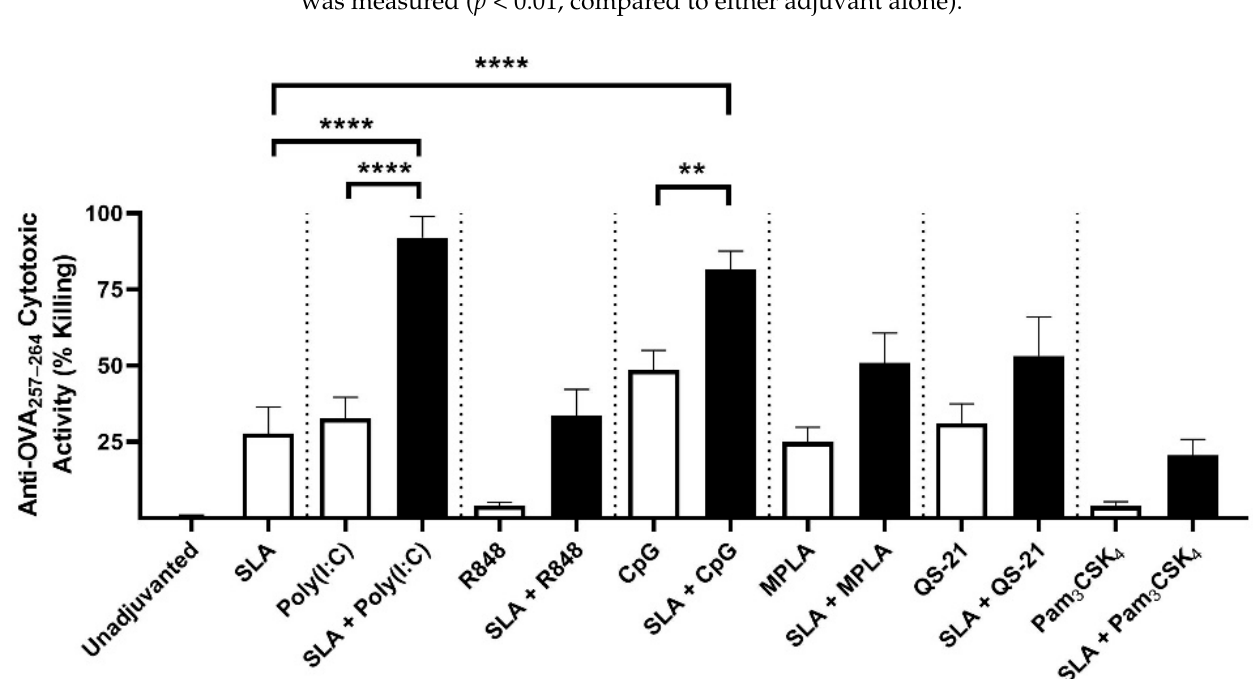
Figure 3. In vivo CTL activity induced by adjuvant combination vaccine formulations. Mice were immunized with vaccine formulations containing OVA antigen alone or formulated with SLA archaeosomes, other adjuvants (Poly(I:C), R848, CpG, MPLA, QS-21, Pam 3 CSK 4 ) or SLA in combination with other adjuvants. Target cells were formed by pulsing CFSE-labeled splenocytes from naïve mice with CD8 epitopes from OVA and then transferred to immunized mice. On the following day (day 28: 7 days post-2nd immunization), splenocytes were collected and the levels of the target cells determined by flow cytometry. Grouped data are presented as mean + SEM ( n = 10/group). ** represents p < 0.01 and **** represents p < 0.0001.